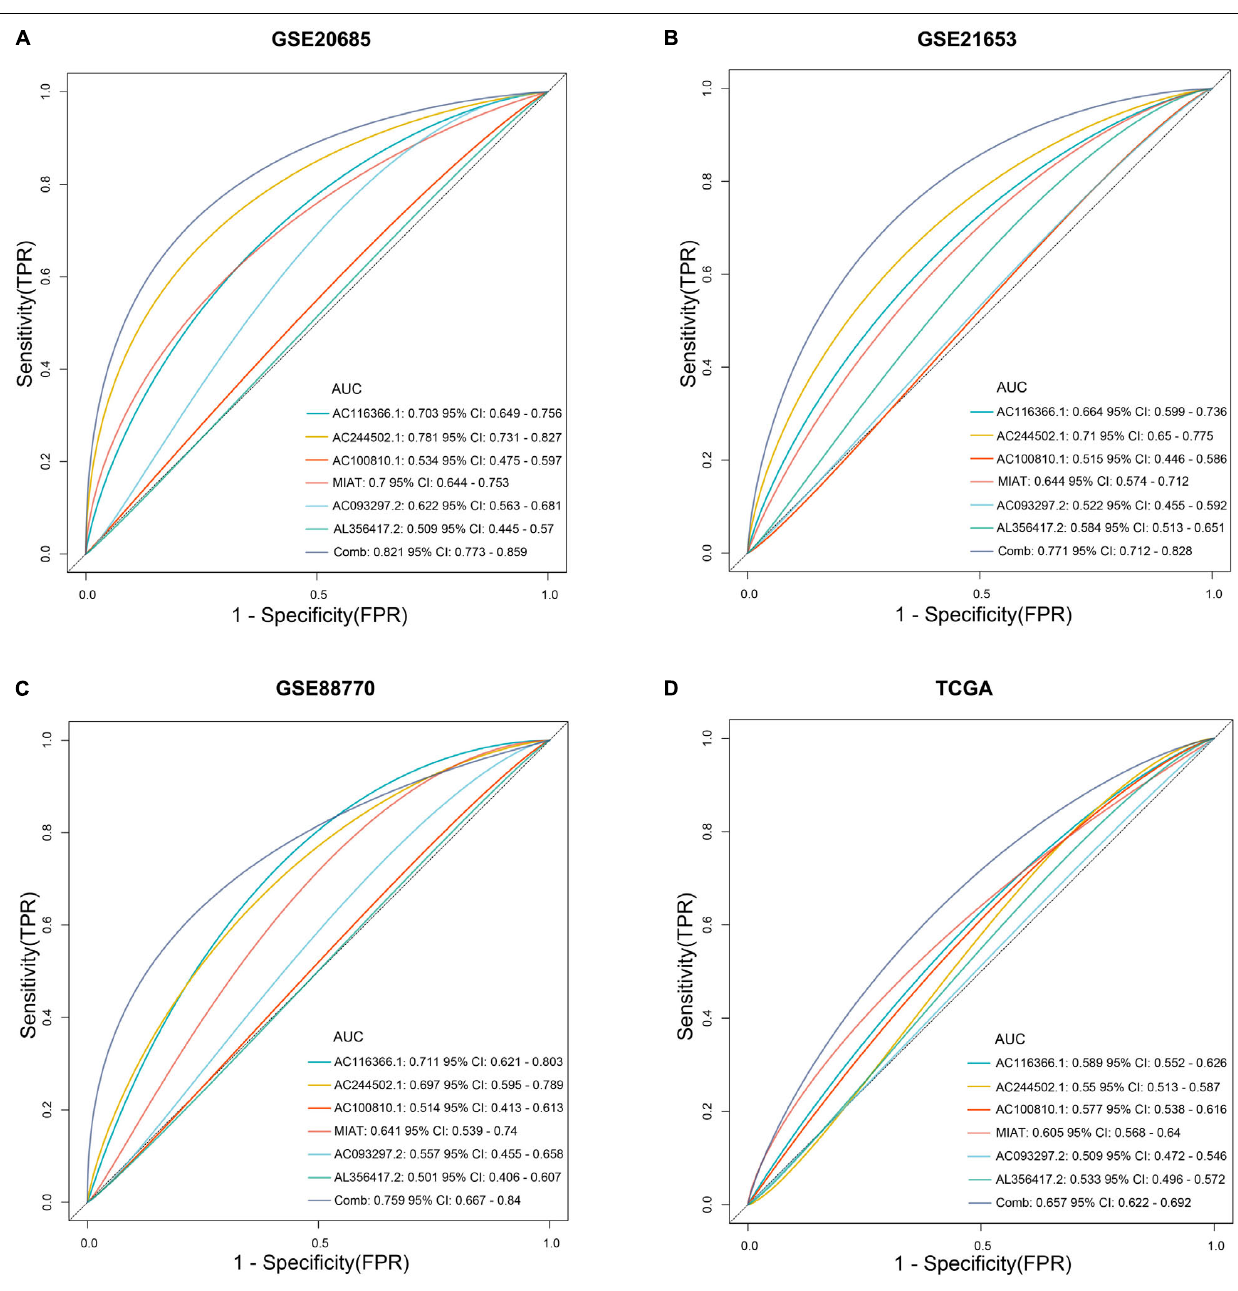
distinguish the test network from the reference network.